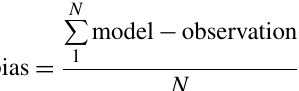
hourly time step, interpolated corresponding to the observed data time step and coordinates. A model bias for each species was calculated as the differ- ence between the simulated and observed concentrations, as shown in Eq. (2), where N is the total number of data points used in the